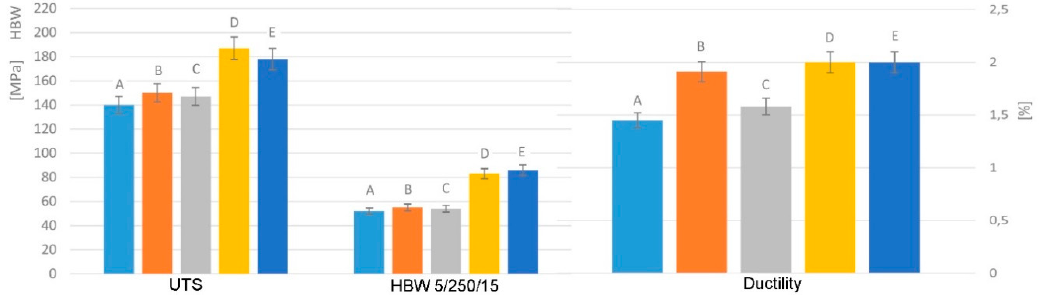
Figure 1. Mechanical properties of experimental materials.